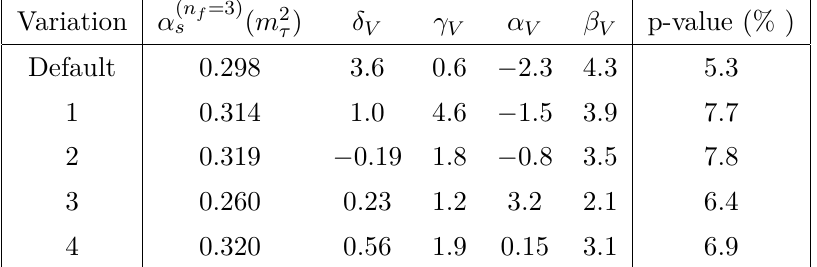
Table 7 . Fitted values of the spectral function ansatz parameters and α ( n f =3) s ( m 2